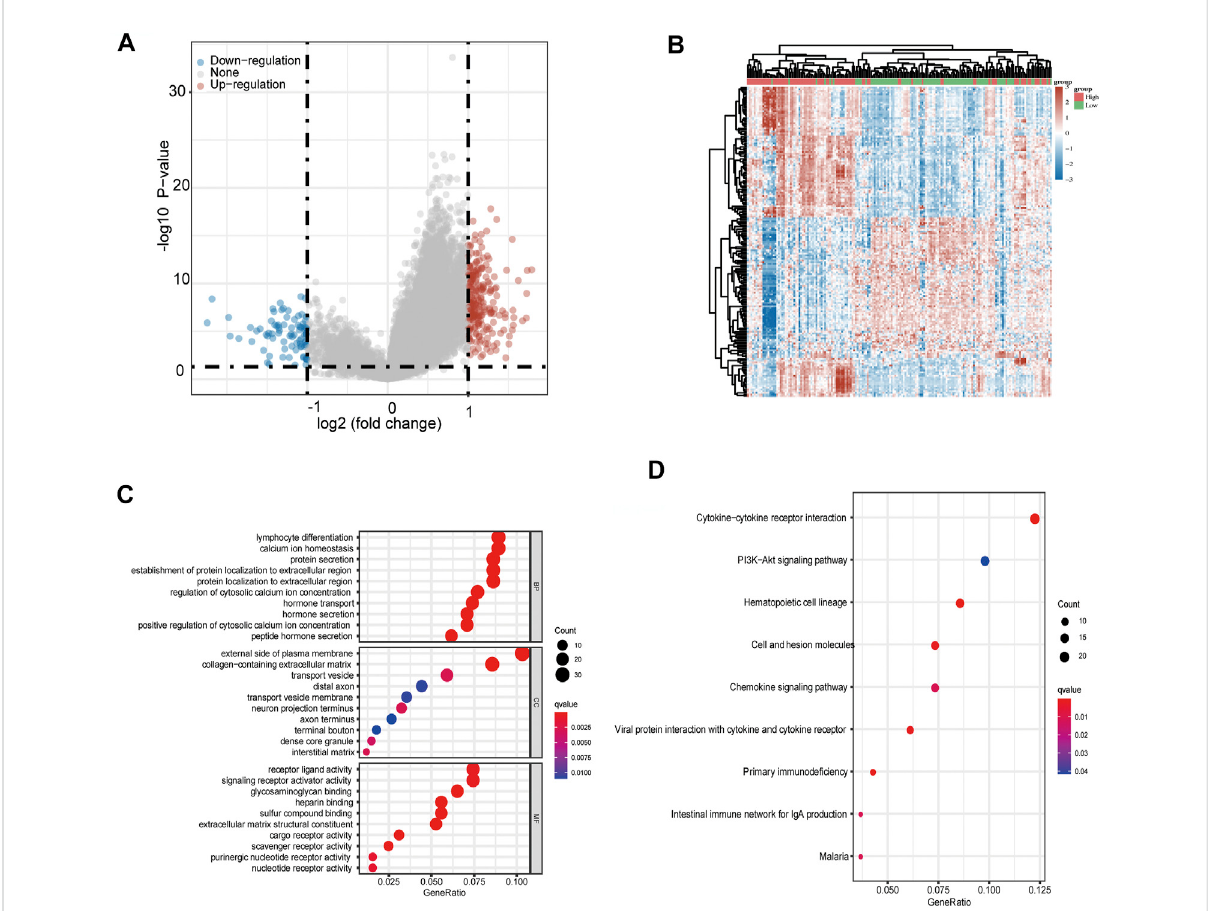
FIGURE 6 GeneenrichmentanalysisofMETTL16inPDA. (A) Volcanoplotsshowingupregulated(red)anddownregulated(blue)DEGsbetweenMETTL16- highand METTL16-lowinTCGA-PAADsamples. (B) Heatmap representationofthetop 50upregulated(red)and top50downregulated(blue) DEGs correlated with METTL16 in PDA. (C) GO analysis of DEGs between METTL16-high and METTL16-low in PDA. (D) Enriched KEGG pathways for DEGs between METTL16-high and METTL16-low in PDA. The X-axis represents the proportion of DEGs, and the Y-axis represents different categories. Colors indicate properties, and sizes represent the number of